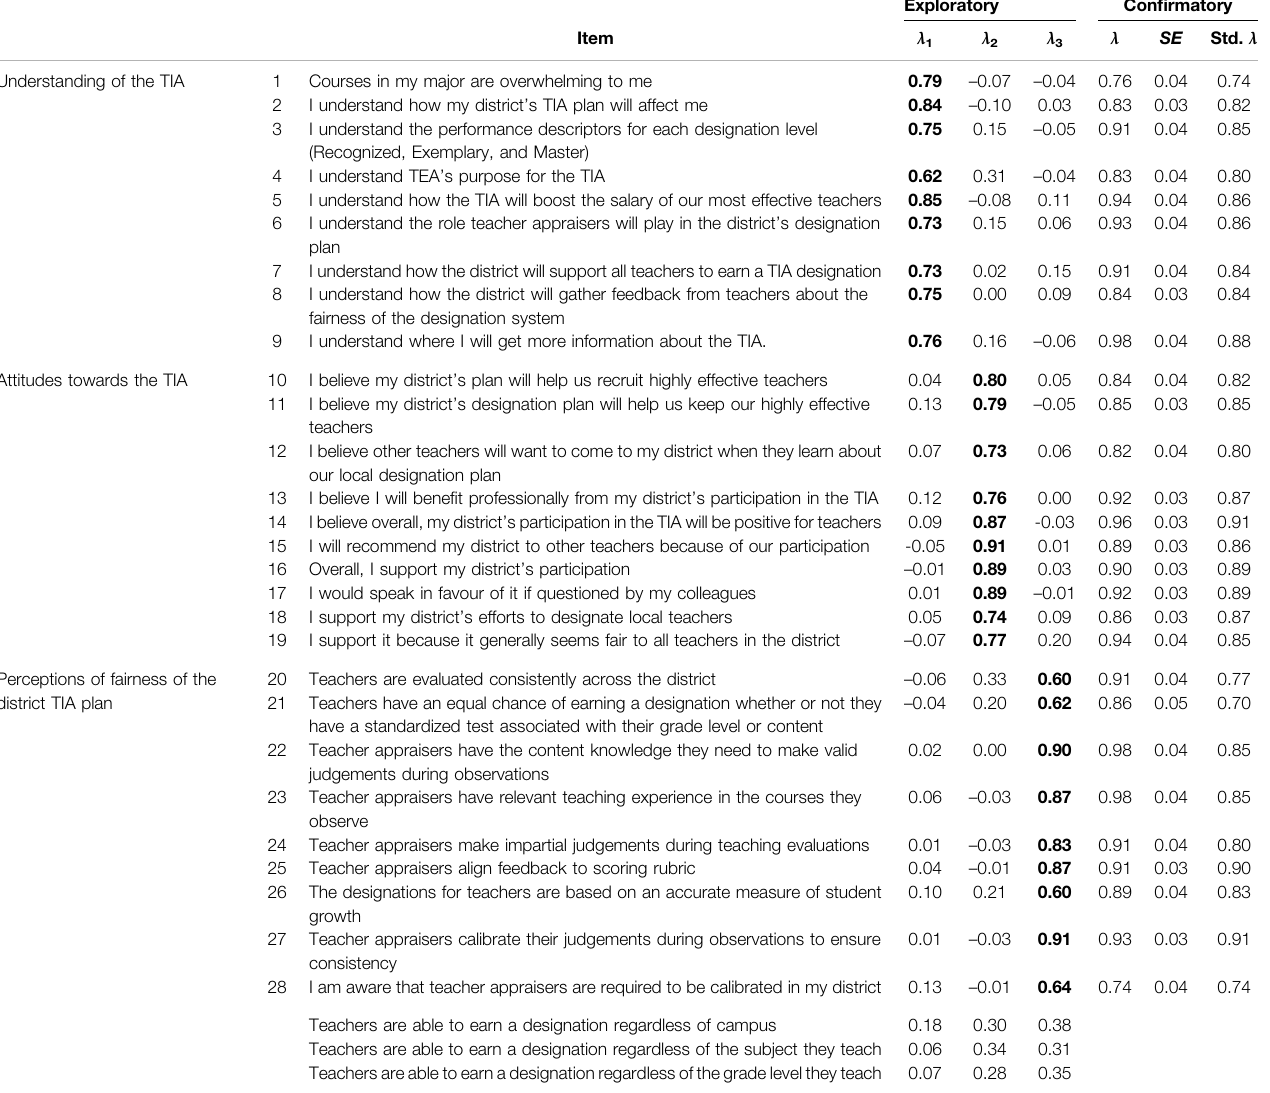
TABLE 1 | Factor loadings from exploratory and con fi rmatory factor